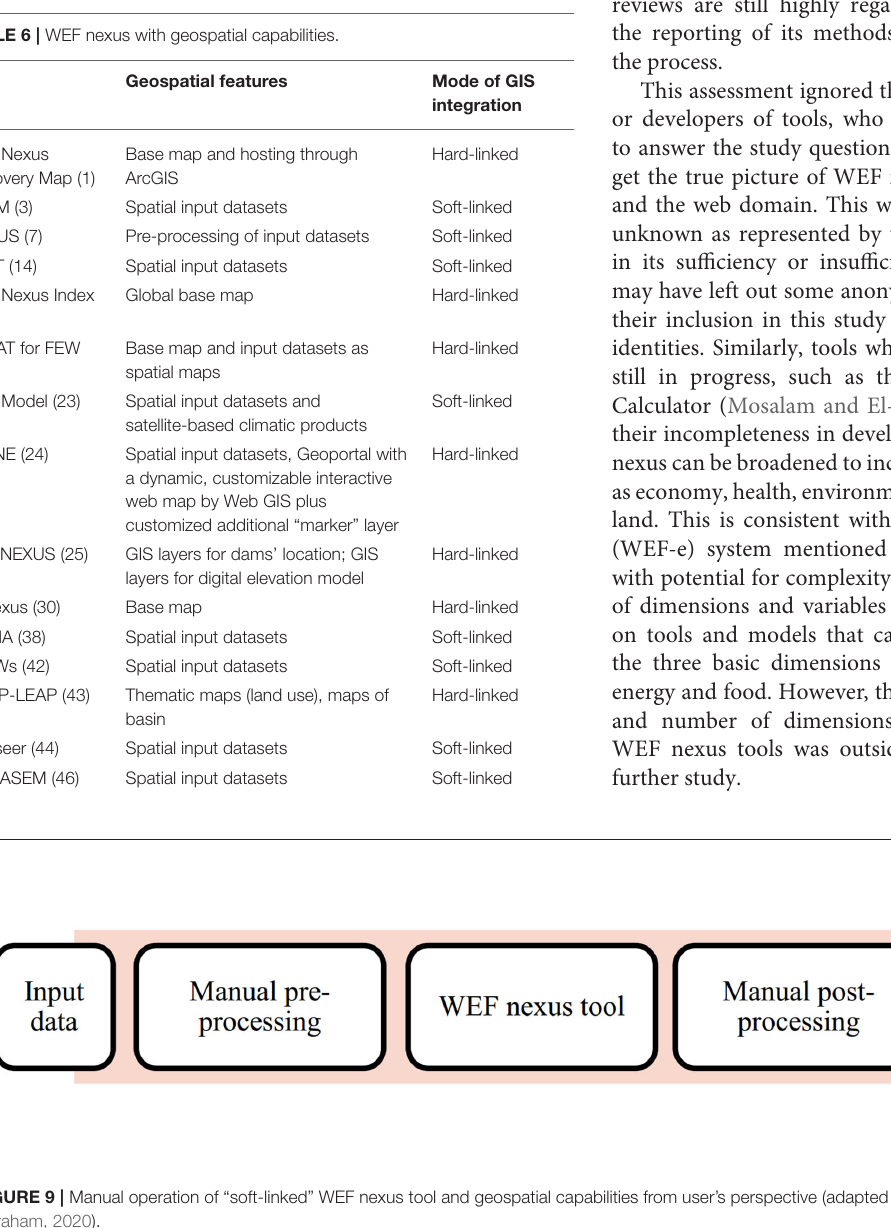
Frontiers in Water |